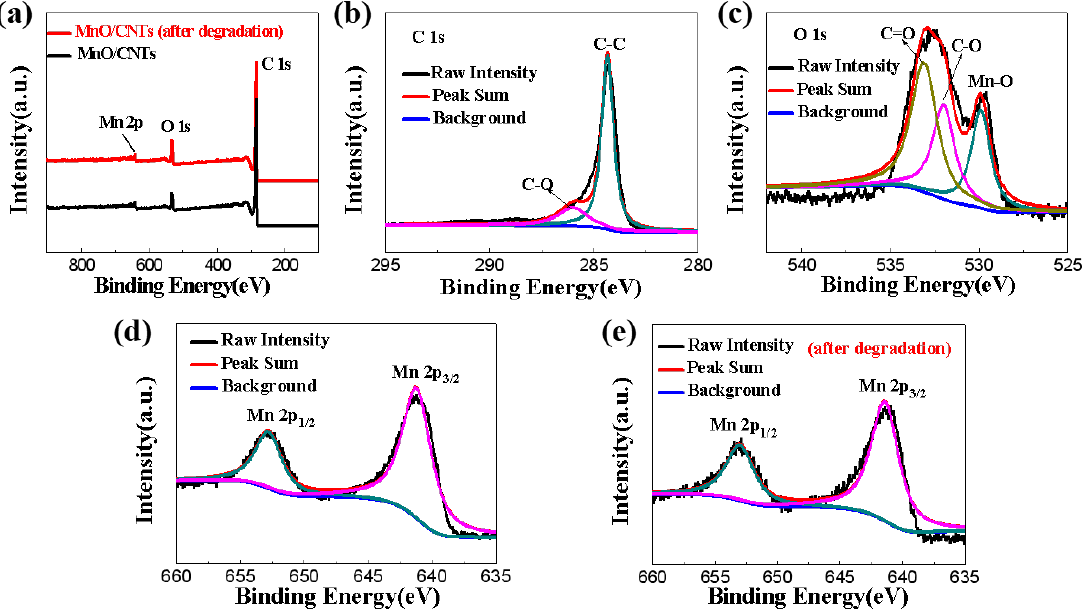
Figure 4. XPS study. ( a ) Full survey of MnO / CNTs and MnO / CNTs after TC degradation under MI, and high-resolution XPS spectra: C 1s of MnO / CNTs ( b ), O 1s of MnO / CNTs ( c ), Mn 2p of MnO / CNTs ( d ), and Mn 2p of MnO / CNTs after TC degradation under MI ( e ).